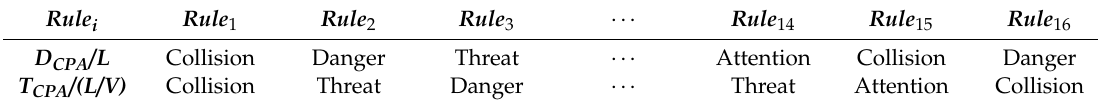
Table 1. Components of the fuzzy inference rules for the T1FIS-NC.